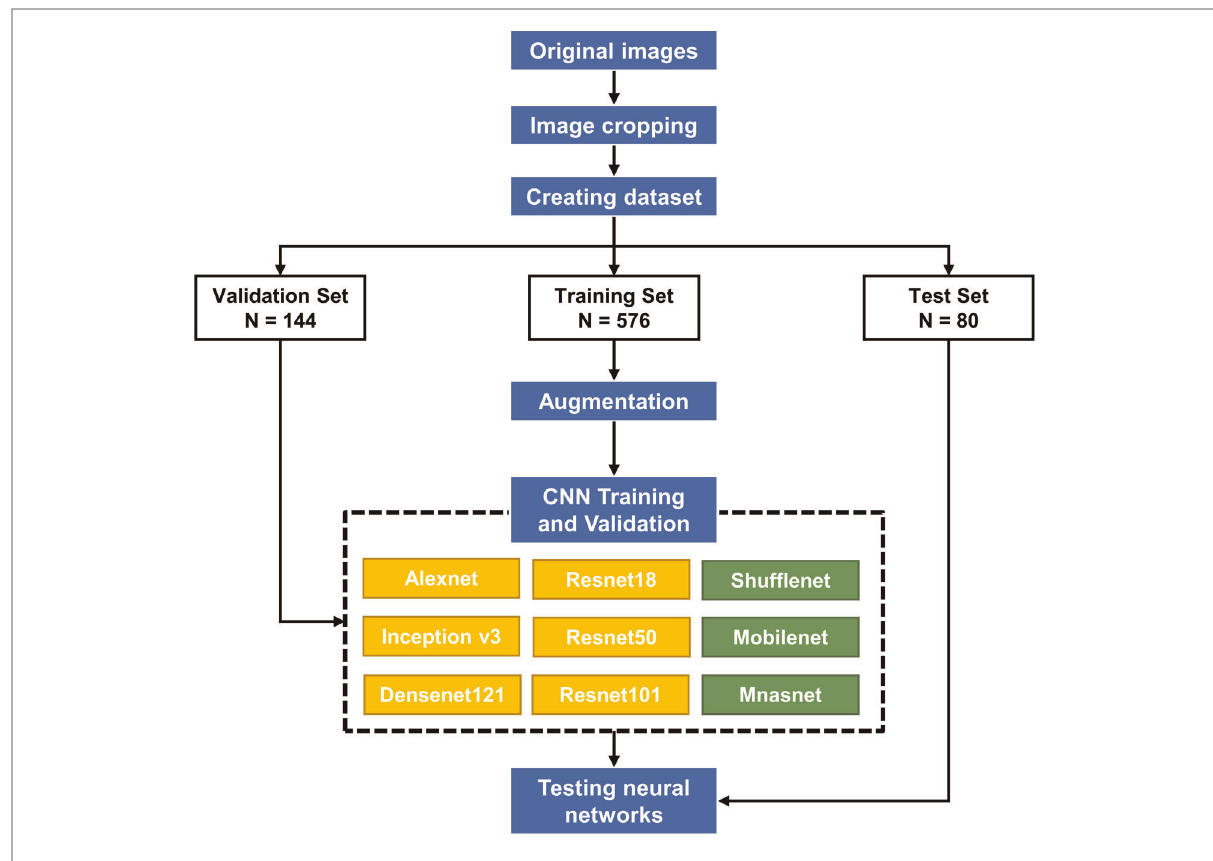
FIGURE 1 The schematic diagram of the whole process.